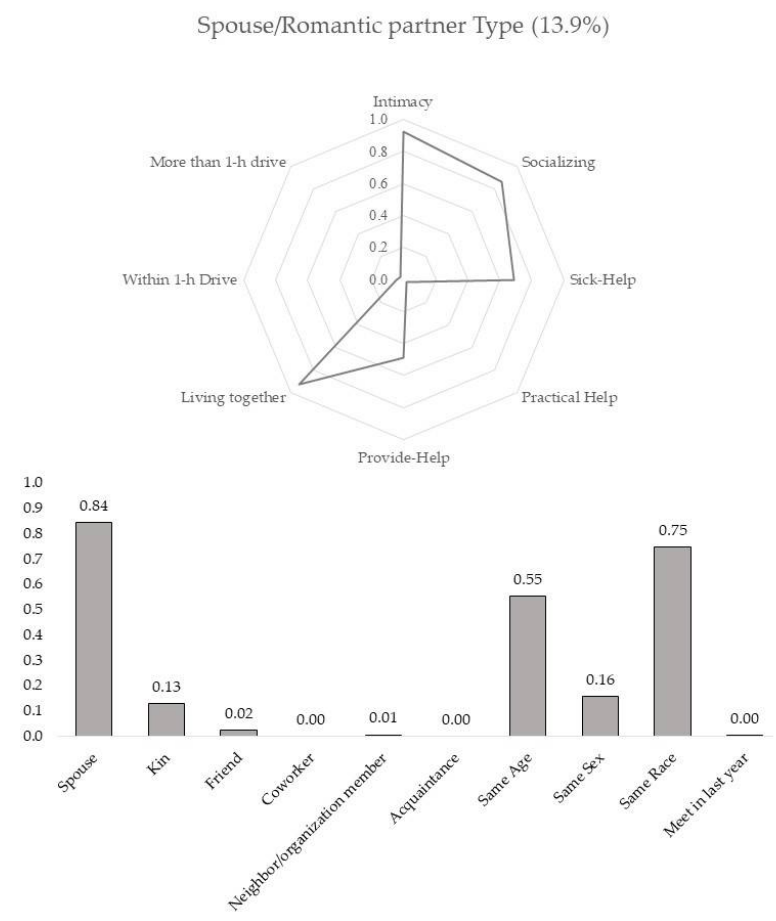
Figure 1. Spouse/romantic partner type.